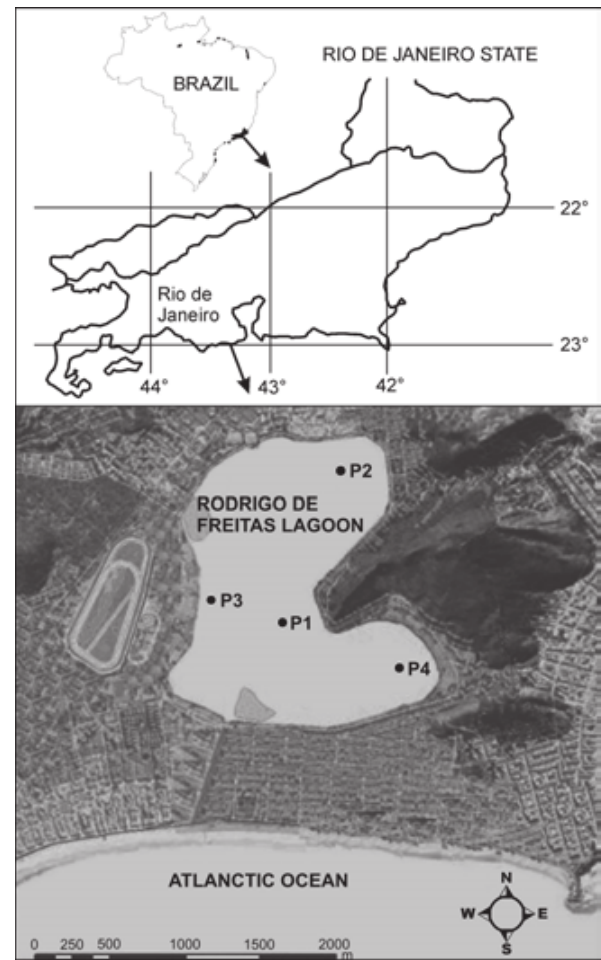
Figure 1. Location of Rodrigo de Freitas Lagoon on the Brazilian coast and and position of sampling